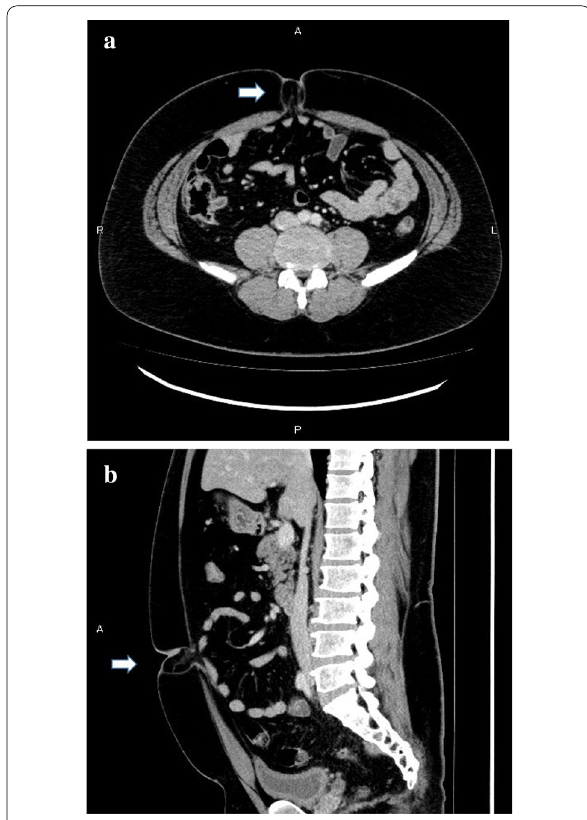
Fig. 2 Sections of enhanced abdominal computed tomography. The greater omentum seems to be incarcerated (arrow). a Horizontal section. b Coronal